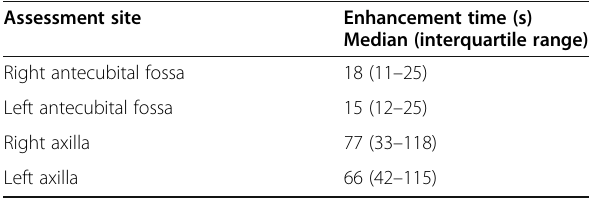
Table 1 Enhancement times in the antecubital fossa and axilla after intradermal injections Assessment